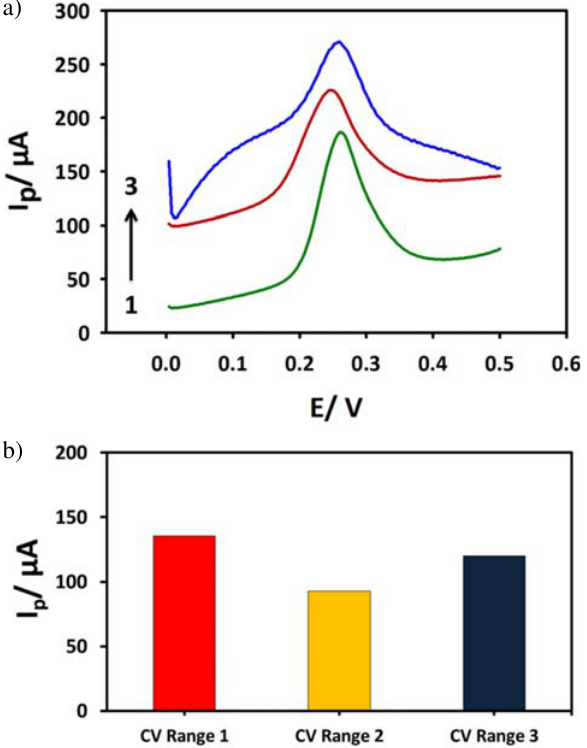
Figure 5: a) Square wave anodic stripping voltammograms (SWASVs) and b) corresponding histograms of 6.2 × 10 –7 mol/L ppb Hg(II) in 0.1 mol/L acetate buffer, pH 5.5 at GPE surfaces and after pretreatment potential ranges of 1) –1.6 to –0.6, 2) –0.6 to 0.6 and 3) 0.6 to 1.6 V. Twenty CV segments were pretreated; other working conditions were identical to those in Fig. 4a.